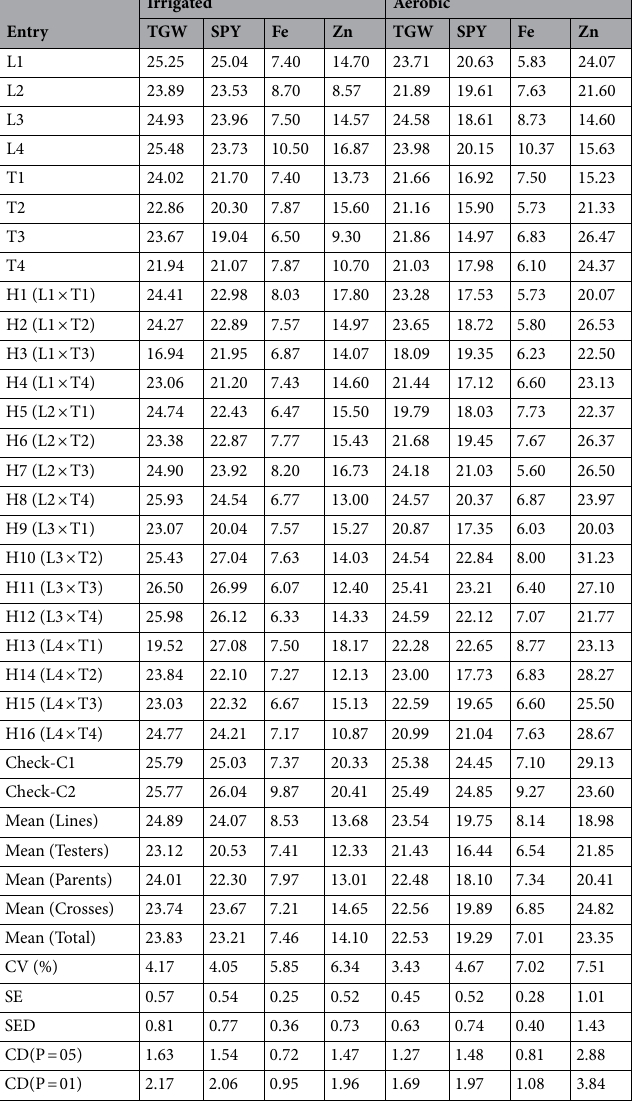
Table 4. Performance of F 1 progenies (Hybrids), parent lines (Lines and Testers) and checks for grain yield, TGW, grain Fe and Zn concentration in Irrigated and Aerobic methods. TGW—1000 Grain Weight; SPY— Single Plant Yield; Fe—Grain Fe content; Zn—Grain Zn content; L1 to L4—Lines; T1 to T4—Testers; H1 to